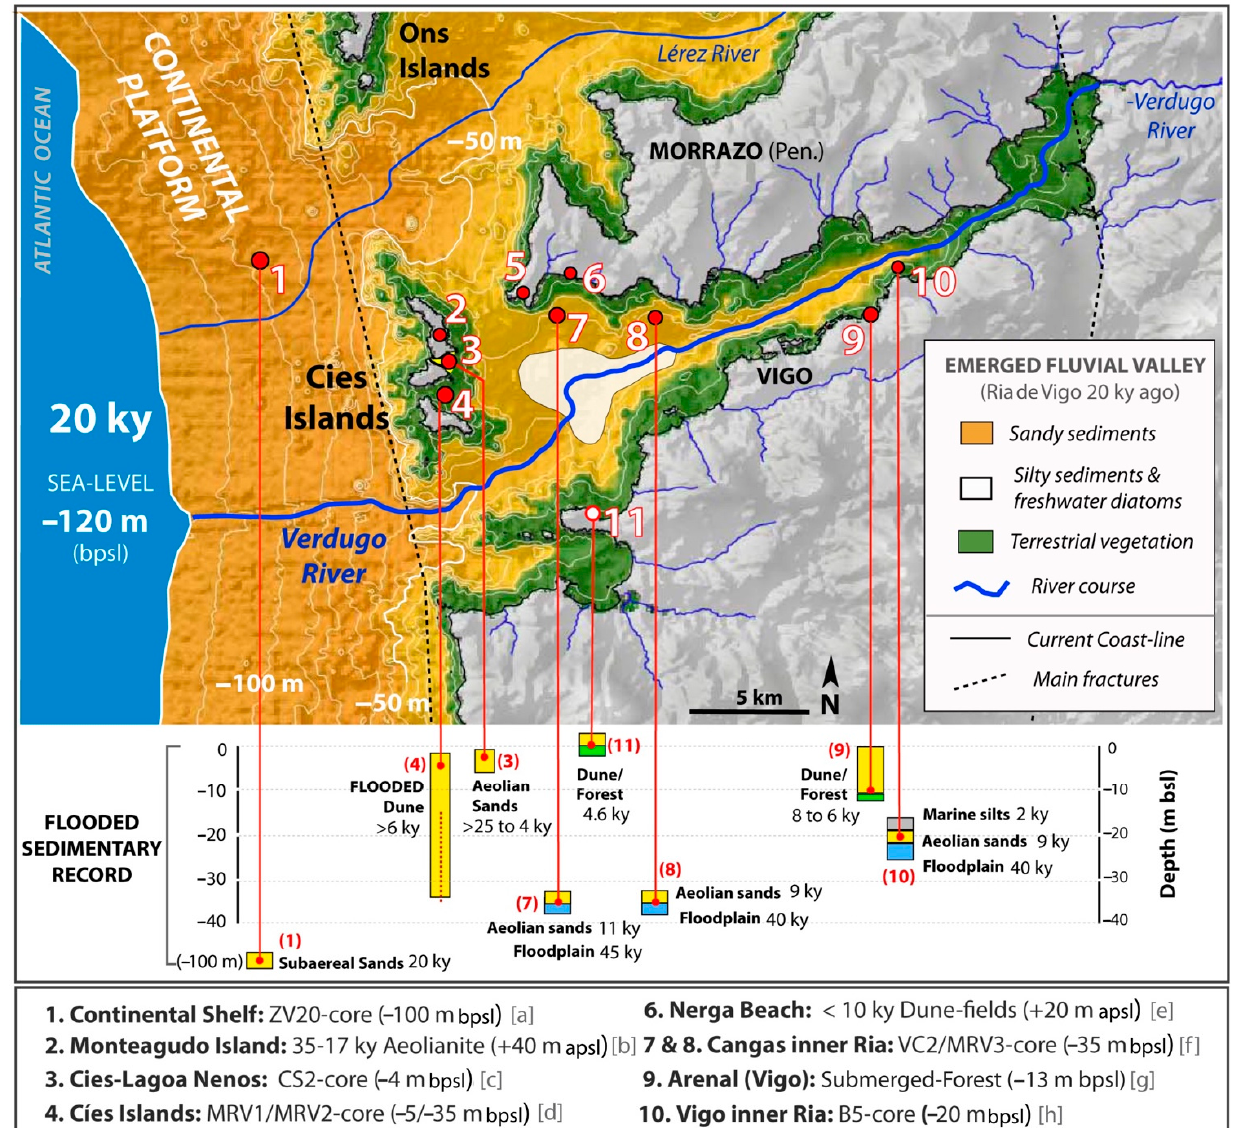
Figure 4. Geomorphology of the Ria de Vigo with sea-level − 120 m below present sea-level (bpsl) at the end of the Last Glacial episode, showing the hypothetical position of the Verdugo River through the emerged fluvial valley; bathymetry from [26]. Green strip shows the advance of terrestrial vegetation and yellow area shows the predominance of sands at the bottom surface [7]. The white area represents silty sediments with freshwater diatoms [27]. Red dots show the main sand deposits related to aeolian sediments—some of them described as marine sediments (7–10) and reinterpreted in this paper as aeolian sands based absolute chronology and depth—[a]: [12]; [b]: [15]; [c]: [8]; [d]: [28]; [e]: [5]; [f]: [10]; [g]: [29]; [h]: [10]; [i]: [30]. Digital elevation database from [31]; apsl: above present